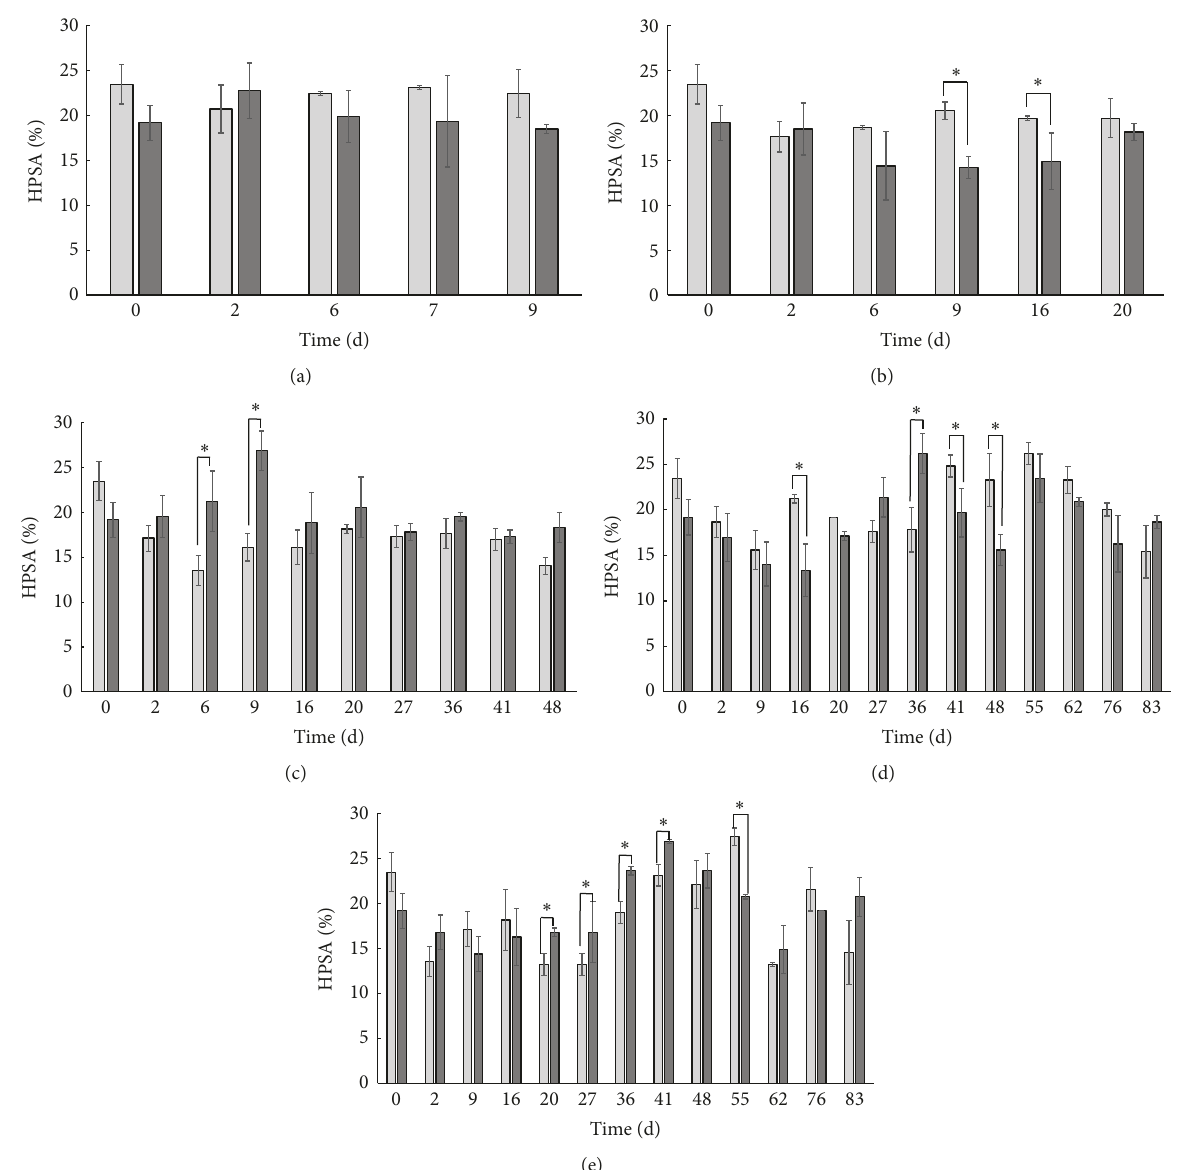
Figure2:Evolutionofthehydrogenperoxidescavengingactivity(HPSA)inblanched(darkbars)andunprocessed(lightbars)broccoliflorets during storage at 20 ∘ C (a), 10 ∘ C (b), − 1 ∘ C (c), − 21 ∘ C (d), and − 45 ∘ C (e). Significant differences ( 𝑝 < 0.05 ) between blanched and unprocessed broccoli are highlighted with “ ∗